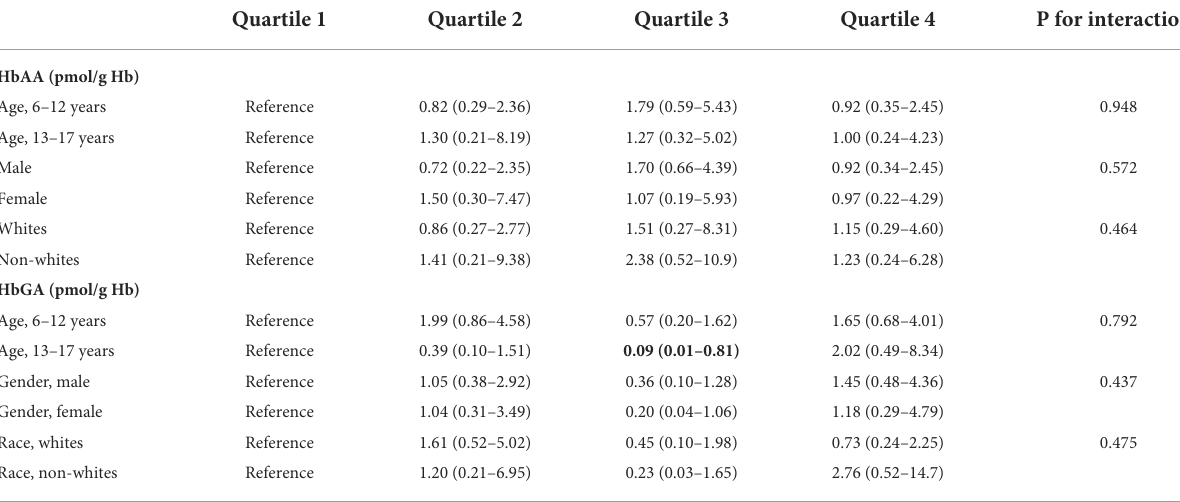
TABLE 3 Interaction analyses of the associations of HbAA and HbGA with developmental disabilities #